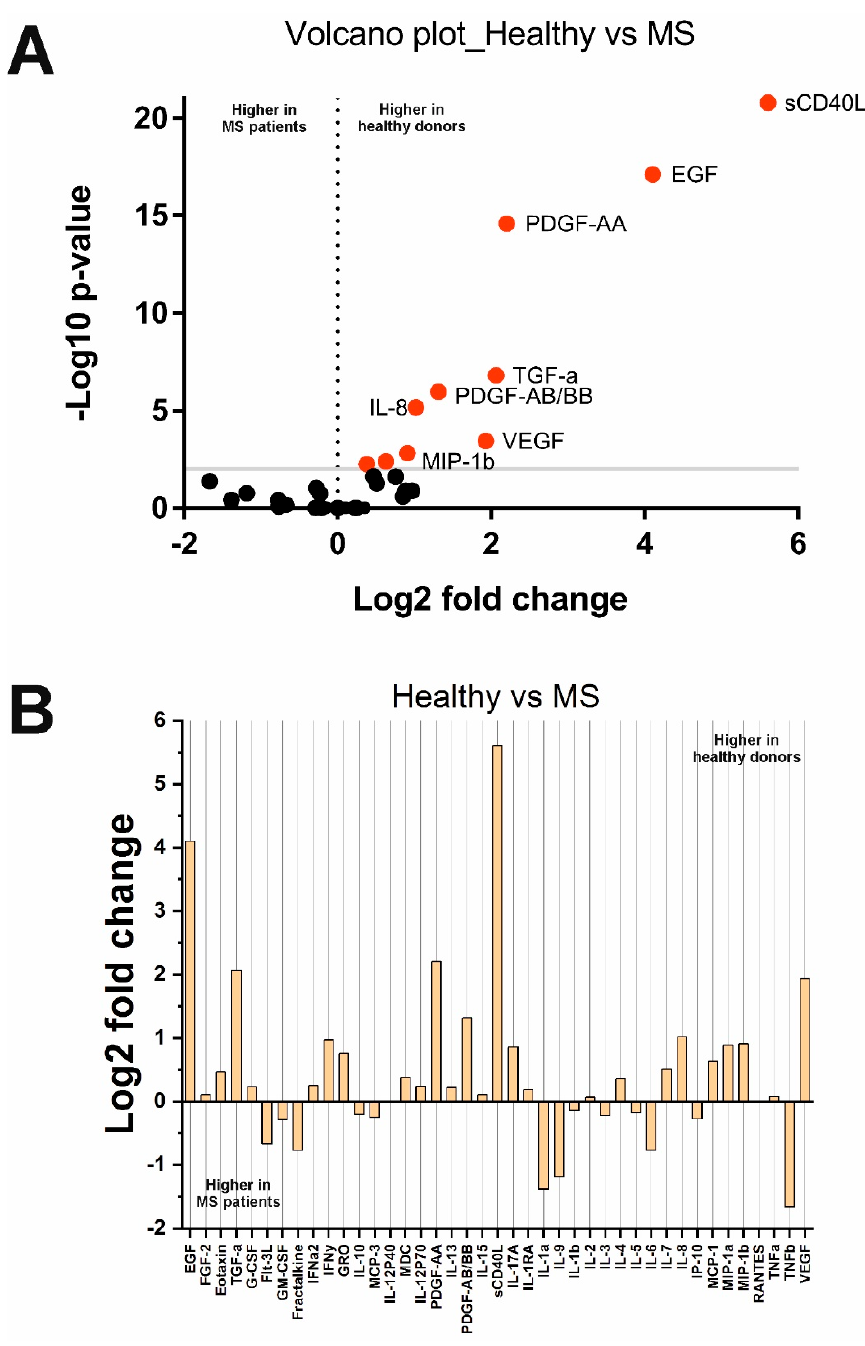
Figure 2. Changes in cytokine concentrations in MS patients compared with healthy donors: ( A ) Vol- cano plot reflecting the dependence of Log2 fold change when pairwise comparing the median values in two groups from − Log10 p -value (red dots indicate significantly changed cytokines); ( B ) Log2 fold change in the concentration of 41 cytokines in the two